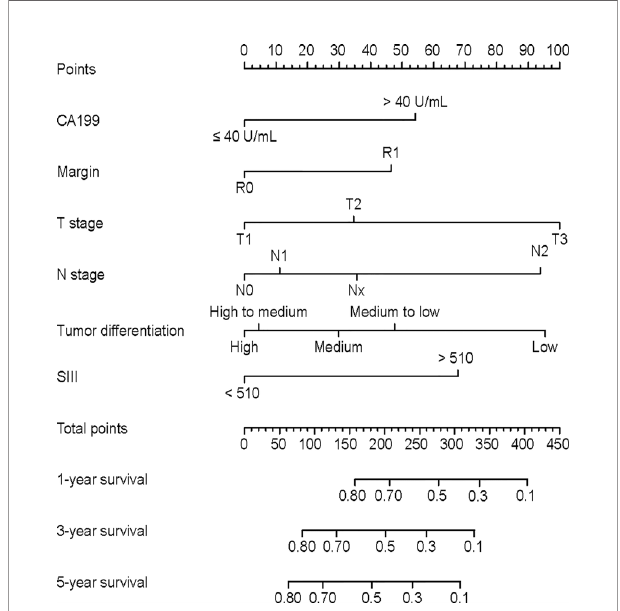
FIGURE 2 | Nomogram for predicting overall survival in GBC